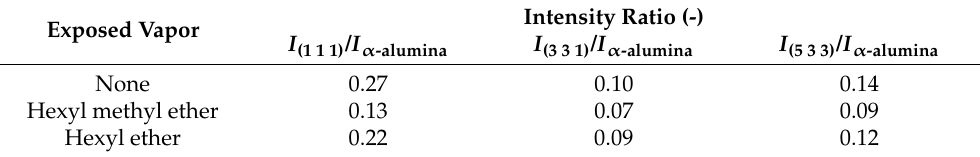
Table 3. XRD peak intensity ratio of the FAU membranes immersed in the